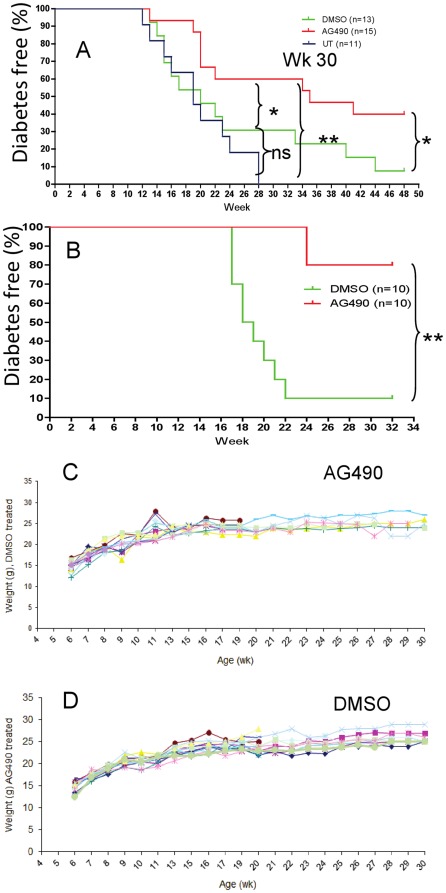
AG490 prevents development of autoimmune diabetes.Prediabetic female NOD mice at 4 (UT: n = 11; DMSO: n = 13; and AG490 treated mice: n = 15 mice/group) (A), or at 8 week of age, (n = 10 per group) (B) were treated with AG490 or DMSO (i.p) for 5 consecutive week, three time per week followed by once a week for 5 more week [Kaplan-Meier test (*p = 0.02, 1A) and (**p = 0.005, 1B, at week 30)]. Our data also indicate that significant differences (p<0.01) was observed between the AG490 and DMSO treated mice for up week 52; when treatment was started at week 4. Body weight of NOD mice treated with AG490 (C) or DMSO (D) in mice when treatment initiated from 4 weeks of age is shown. [This figure is intended to be in color online and black and white in print.]